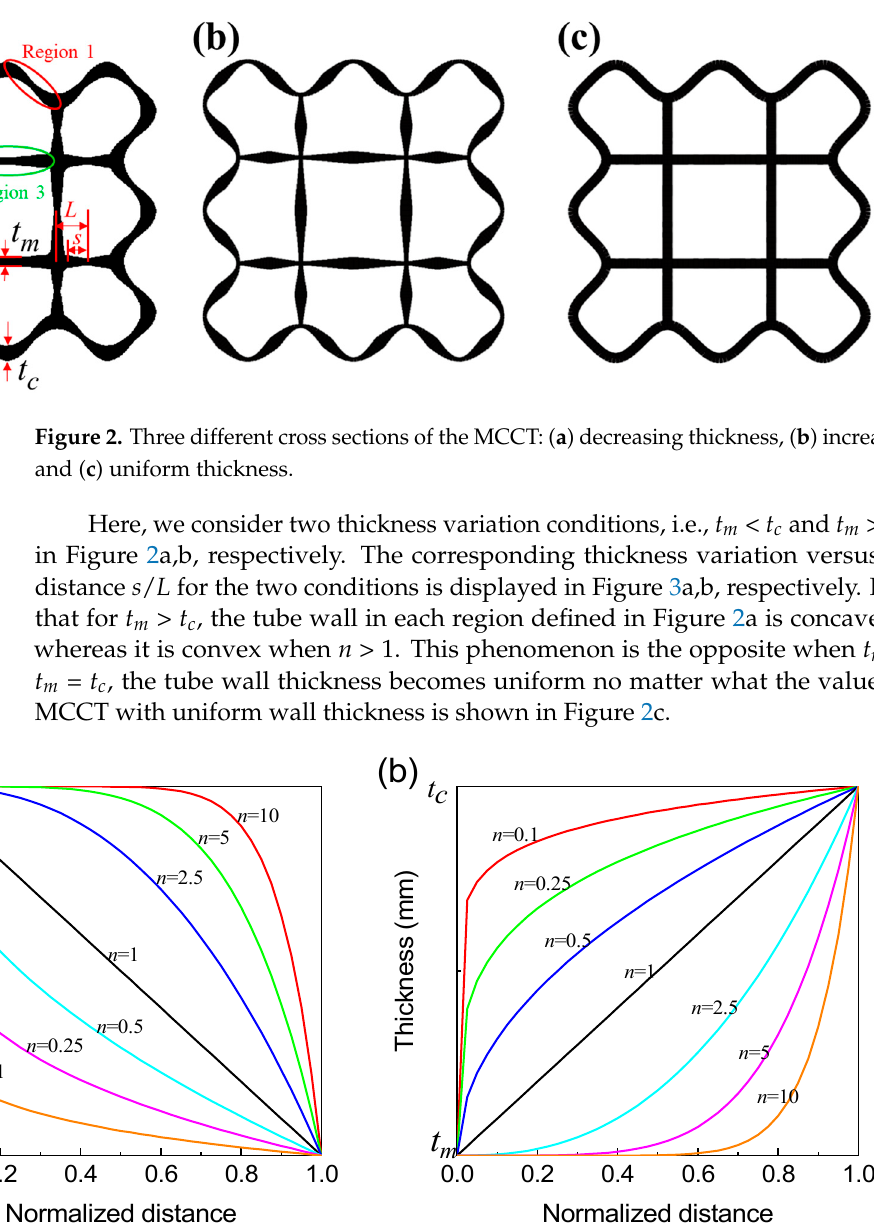
Figure 1. Cross-sectional configuration of the MCCT.